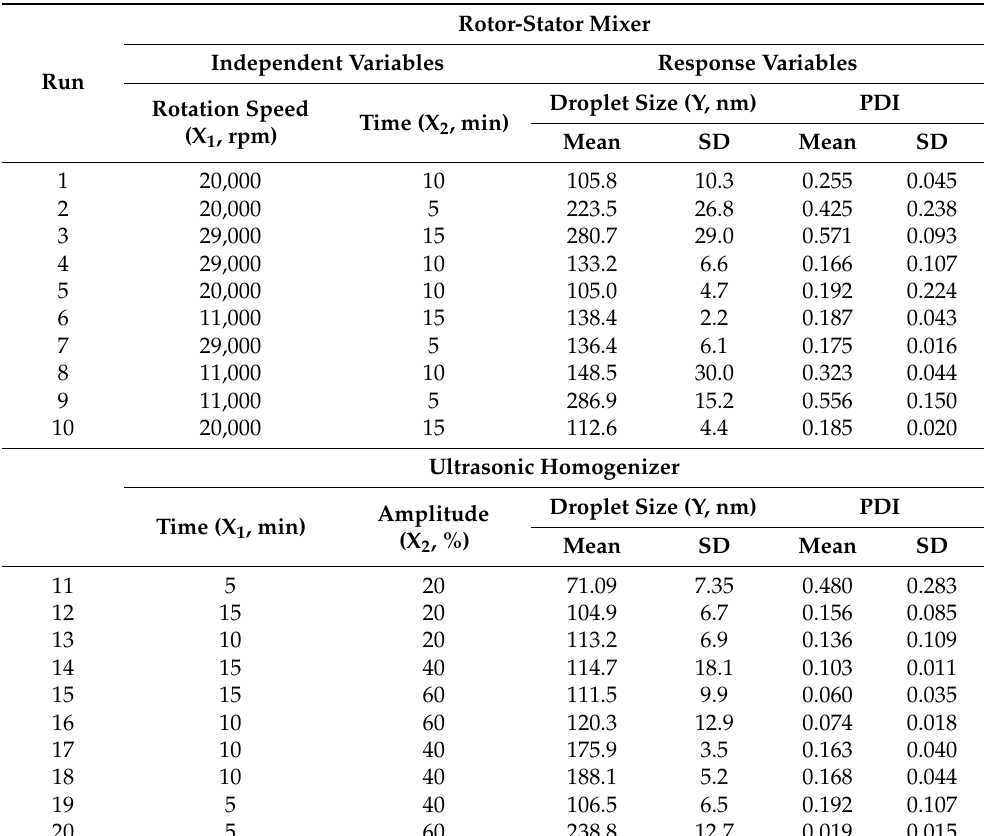
Table 3. Matrix of the CCD and experimental data for W/O emulsion preparations using two high-energy emulsification methods.